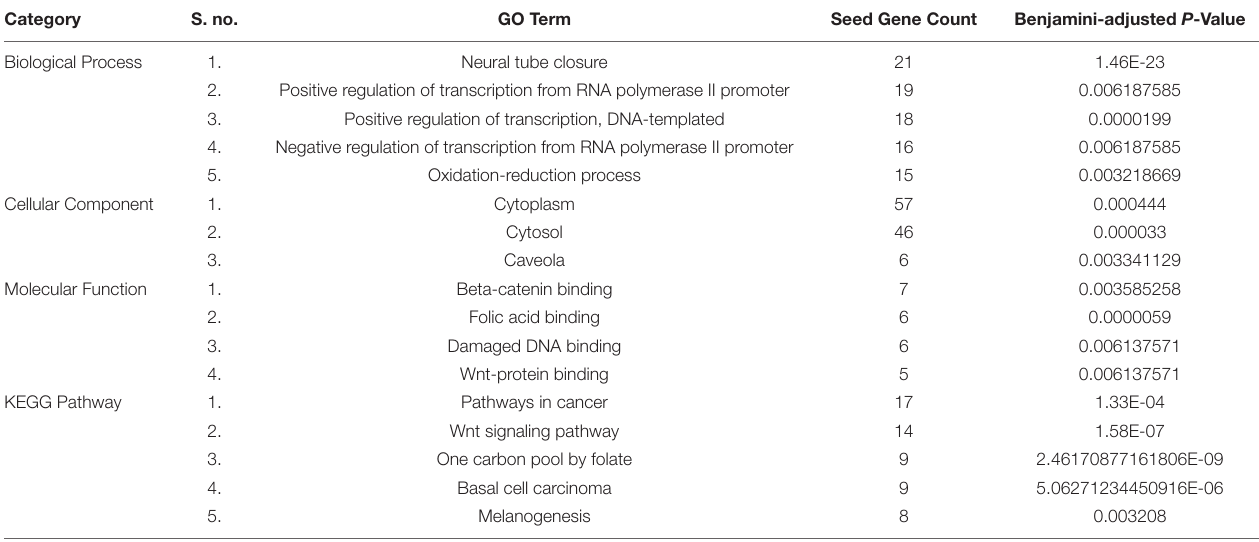
TABLE 2 | Functional and pathway enrichment of the SB network’s seed genes. Category S. no. GO Term Seed Gene Count Benjamini-adjusted P -Value Biological